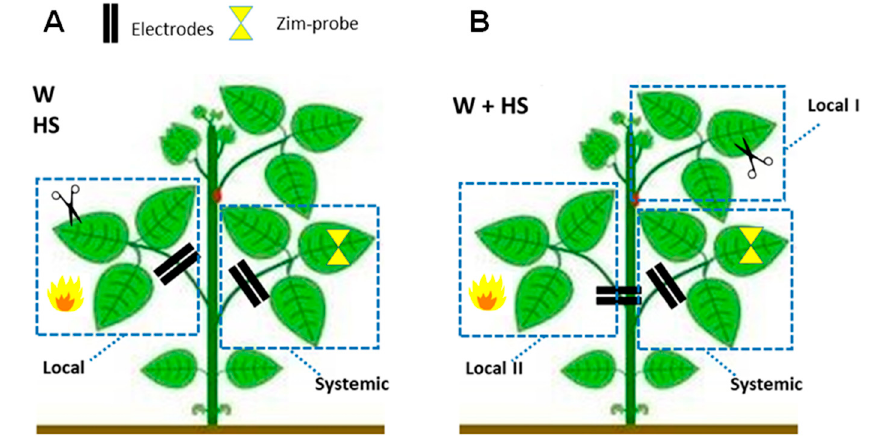
Figure 10. Representation of the experimental design indicating the place of application of the stimuli (W, HS, and W+HS) and where the systemic evaluation of the signals was performed. ( A , B ) The dashed rectangular border indicates the location (local tissue) where the different stimuli were applied. The yellow hourglass represents the turgor pressure probe installed on the systemic sheet. The two black lines indicate the electrode insertion region.